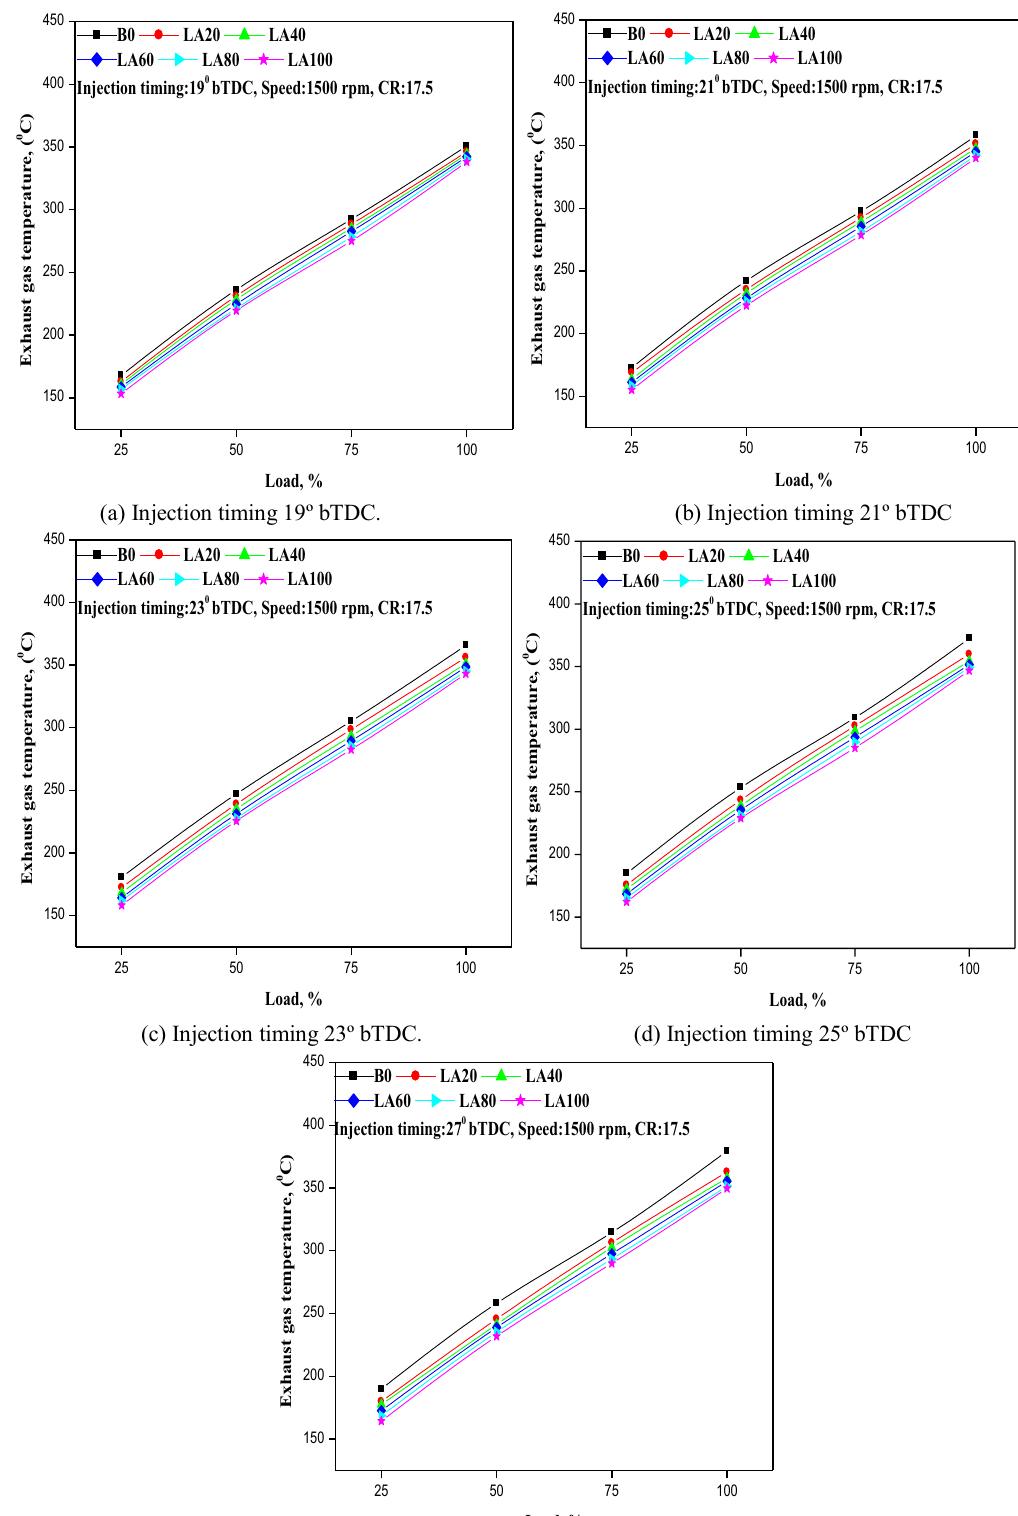
Figure 6. ( a–e ) The variation in EGT with different injection timing and engine load for different